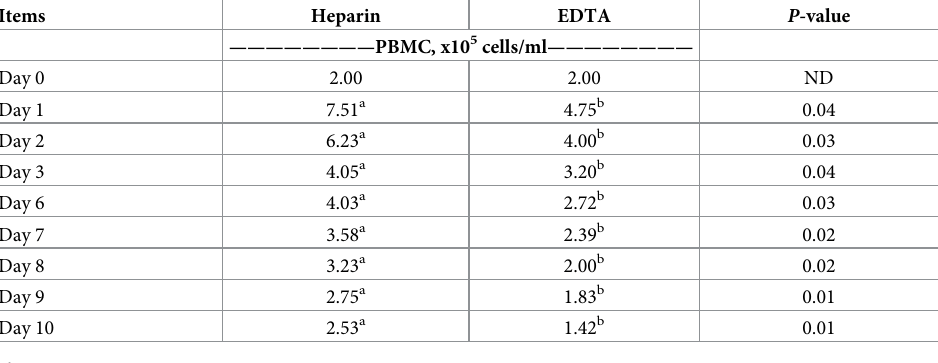
Table 2. Effect of blood anticoagulants on the peripheral blood mononuclear cells (PBMCs) isolation in Varanus salvator . Items Heparin EDTA